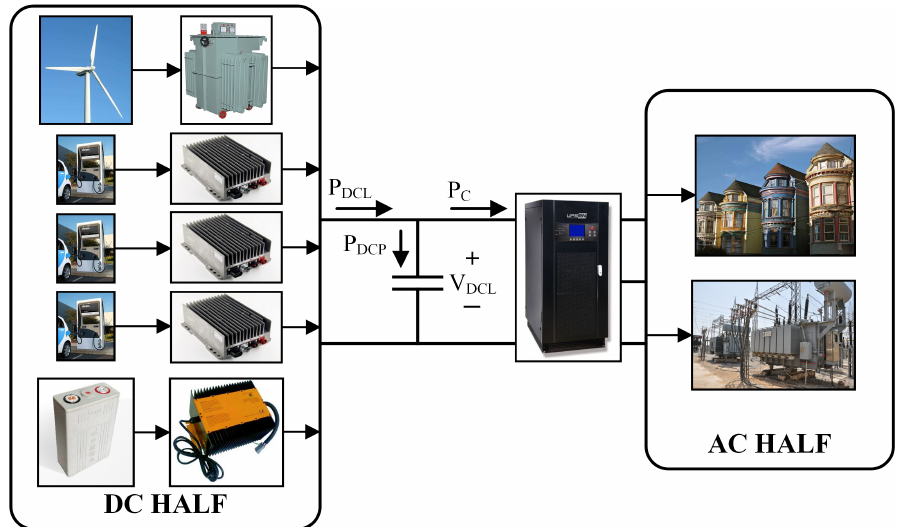
Figure 2. Equivalent structure of the proposed charging